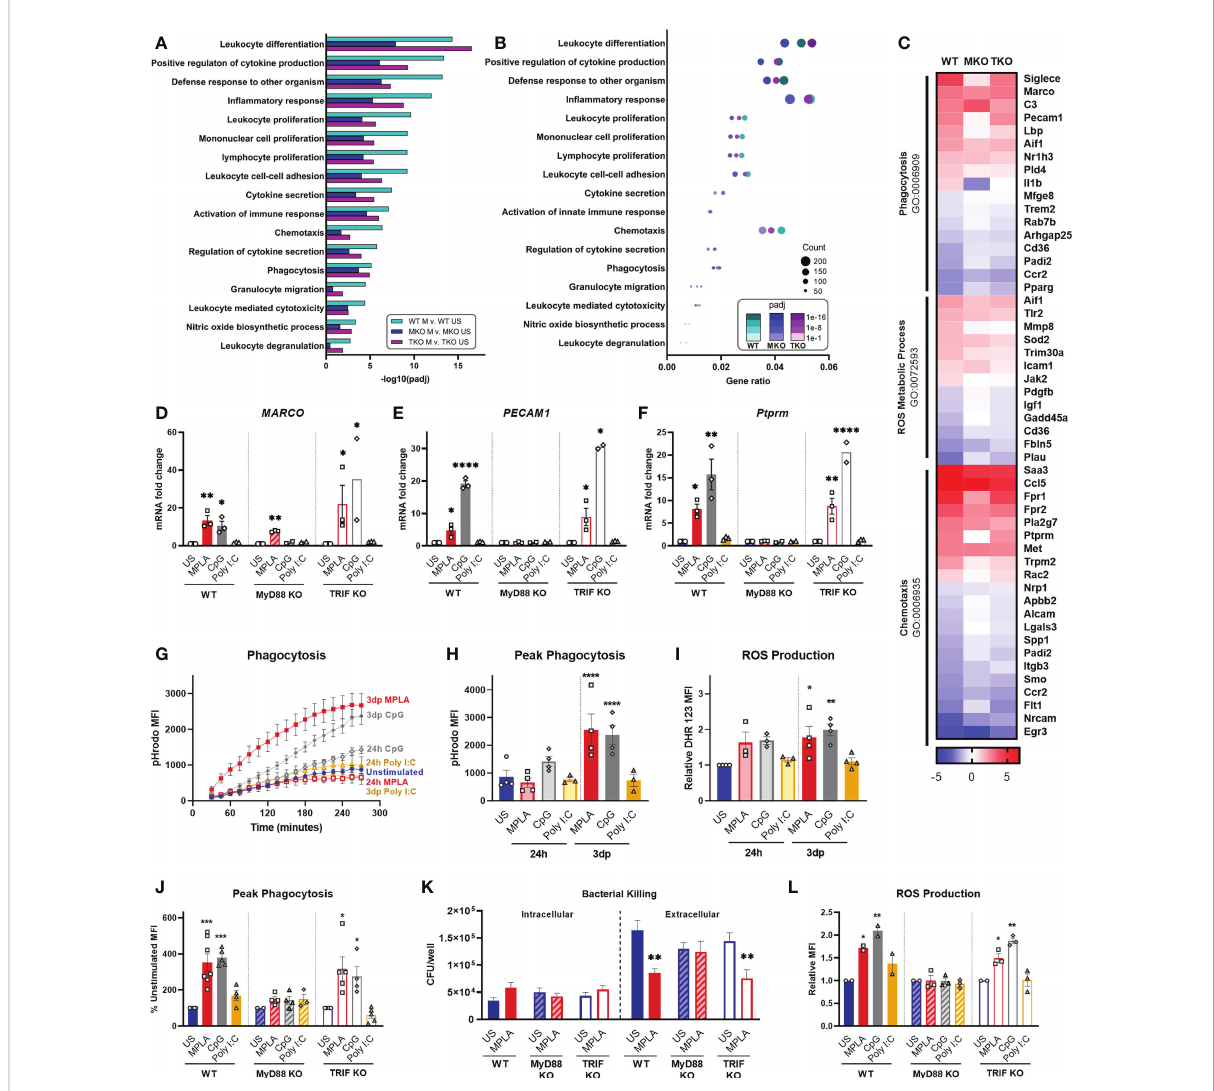
FIGURE 6 TLR agonist-induced augmentation of antimicrobial capacity is blocked in MyD88-KO, but not TRIF-KO, macrophages. (A, B) Gene ontology (GO) functional enrichment analysis was conducted for immunology-related pathways and displayed by signi fi cance of pathway induction (A) and by dot plot which shows number of genes differentially regulated in each respective pathway (i.e. “ count ” ) by dot size and degree of signi fi cance (padj) by intensity of color (B) . (C) Immune function-related GO pathways were evaluated by heat map comparing MPLA-trained WT, MyD88-KO (MKO), and TRIF-KO (TKO) BMDMs to unstimulated (US) genotype controls. (D-F) Relative gene expression of MARCO (D) , PECAM1 (E) and Ptprm (F) of unstimulated control, MPLA, CpG, and Poly I:C-treated WT, MKO, and TKO BMDMs 3 days post-treatment (n=2-3 biological replicates/group). (G, H) The fl uorescence emitted upon phagocytosis of pHrodo-tagged S. aureus bioparticles was measured over 4 hours (G) and peak phagocytosis was analyzed (H) . (I) ROS production was assessed by fl ow cytometry. (J) Phagocytic capacity of MPLA-, CpG-, and Poly I:C-treated WT, MyD88- KO, and TRIF-KO were assessed alongside unstimulated (US) genotype controls. (K) Bacterial killing (S. aureus MOI 10) of MPLA-treated WT, MyD88-KO, and TRIF-KO BMDMs compared to US controls. (L) ROS production capacity was assessed. Data are shown as mean ± SEM, *p < 0.05, **p < 0.01, ***p < 0.001, ***p < 0.0001, ****p < 0.0001 by ANOVA followed by Dunnett ’ s post-hoc multiple comparison